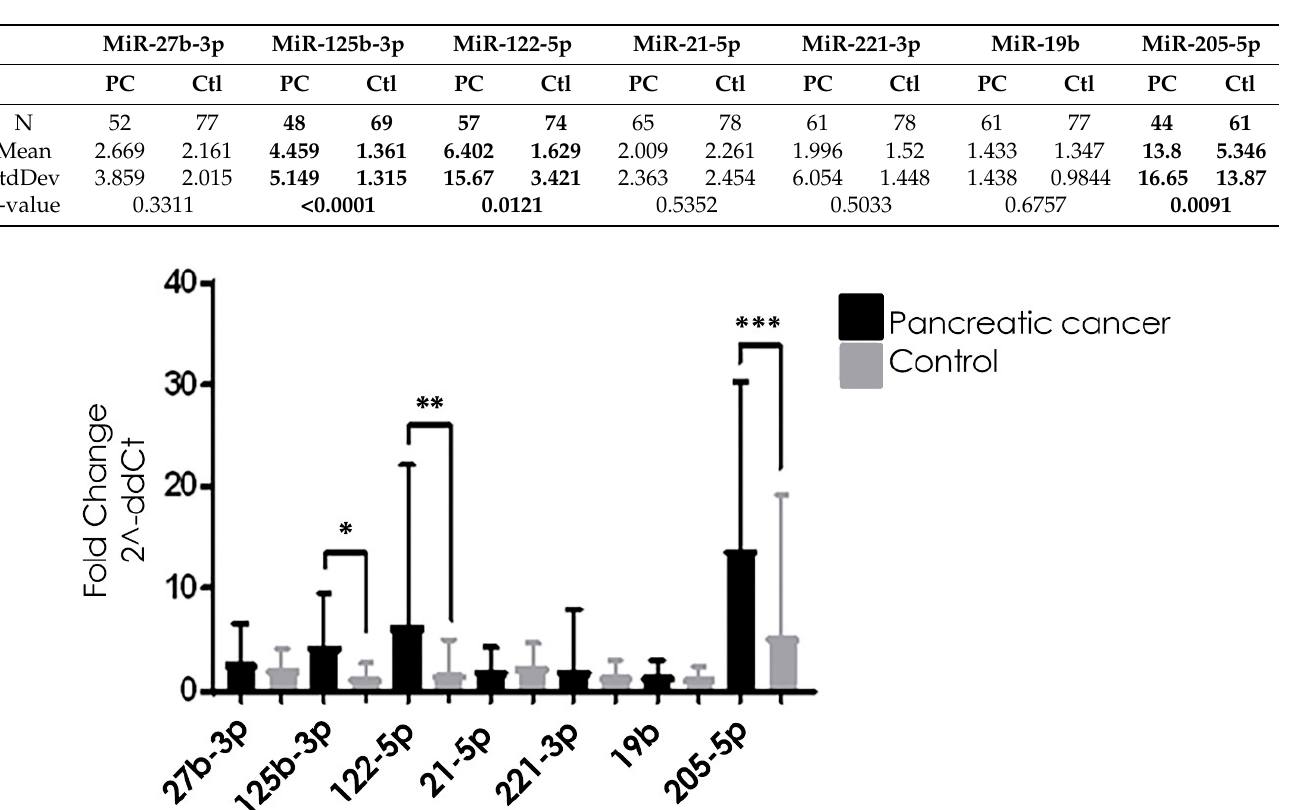
Table 3. Statistical evaluation of miRNA expression in pancreatic cancer patients (PC) compared to the healthy control group (Ctl). Significantly higher expression was observed in miR125b-3p, miR122-5p, and miR205-5p in pancreatic cancer patients than healthy controls. The values are calculated by 2 − ΔΔ Ct (StdDev: Standard Deviation).